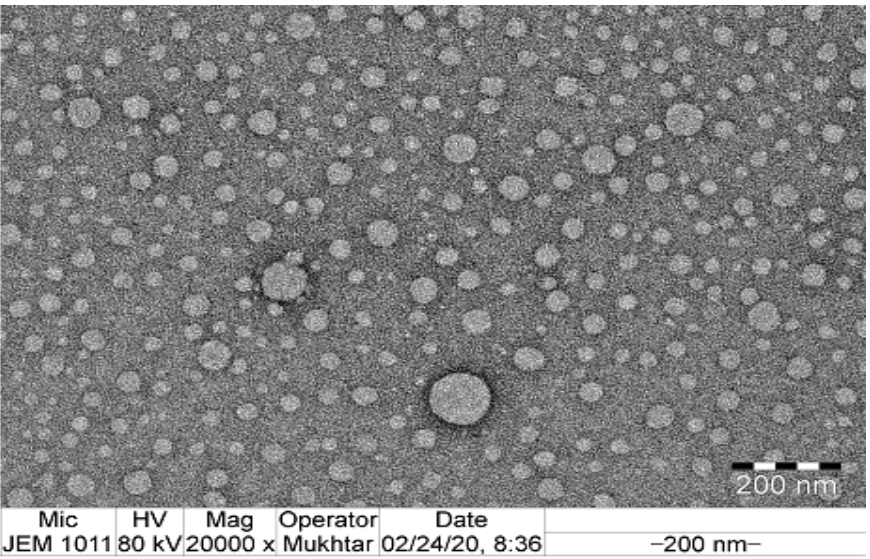
Figure 6. TEM image of the optimized naringenin nanoemulsion.